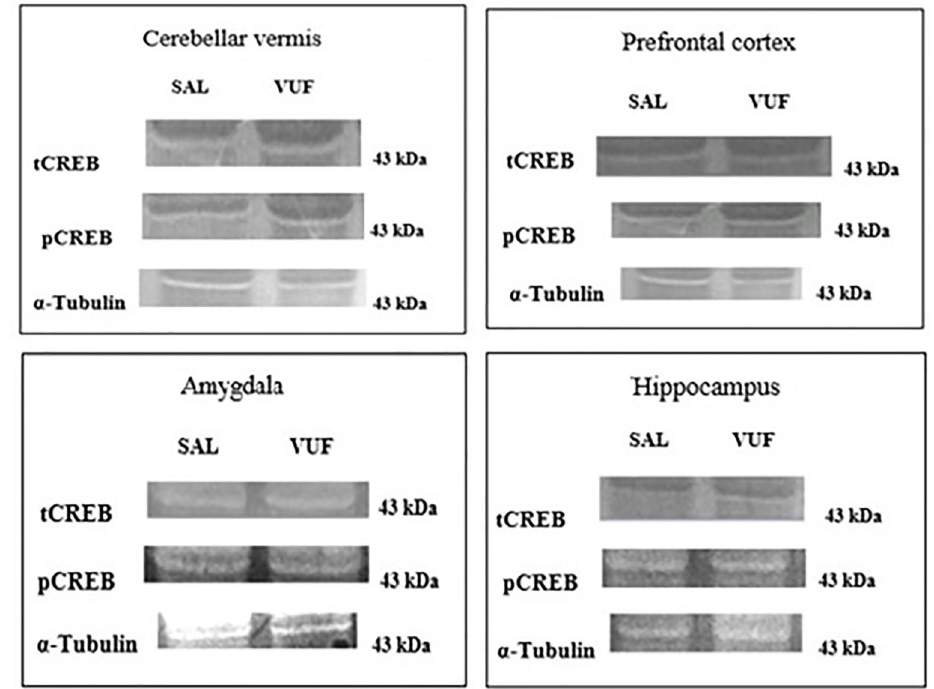
Figure 1. Representative membranes with fl uorescence bands from the western blot analysis of total CREB (tCREB), phosphorylated CREB (pCREB), and a -tubulin in the cerebellar vermis, prefrontal cortex, amygdala, and hippocampus in mice. SAL: 9% saline group; VUF: 500 ng/kg VUF-8430-treated